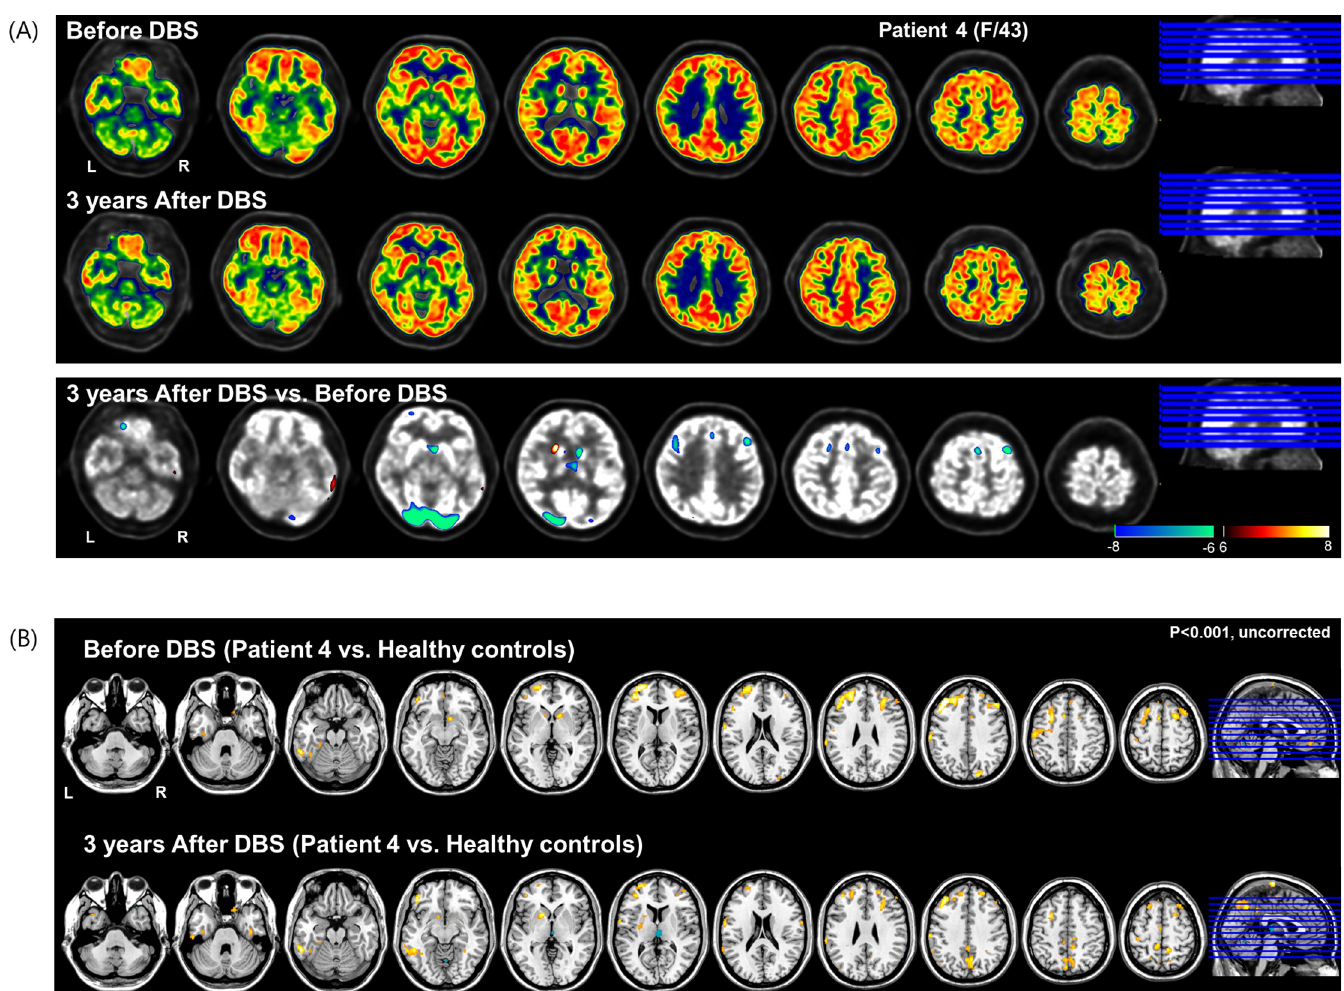
Fig 5. 18 Fluorodeoxyglucose-positron emission tomography (FDG-PET) scan taken before and after NAc DBS in Subject four. (A) After DBS, FDG uptake in bilateral frontal including anterior cingulate and occipital region was decreased compared to before DBS. (B)Relative to healthy controls, the hypermetabolic activity in frontal regions after DBS was less extensive than before DBS (p < 0.001, uncorrected for multiple